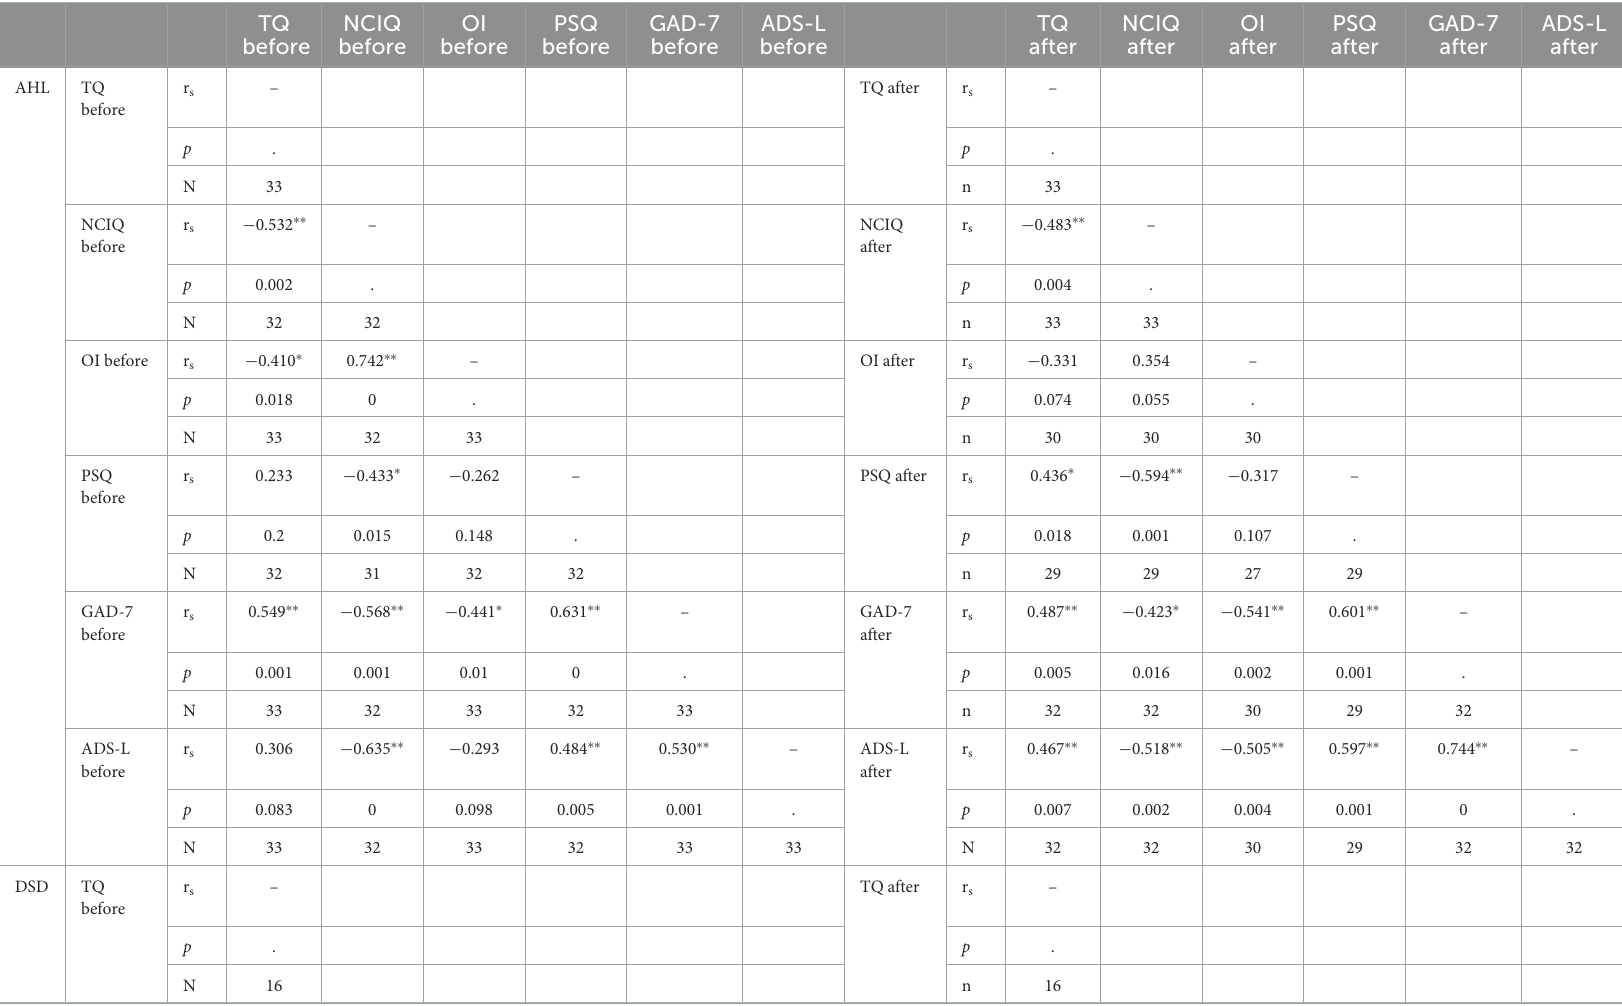
TABLE 3 The Spearman correlation was computed for the main variables before and after implantation. TQ